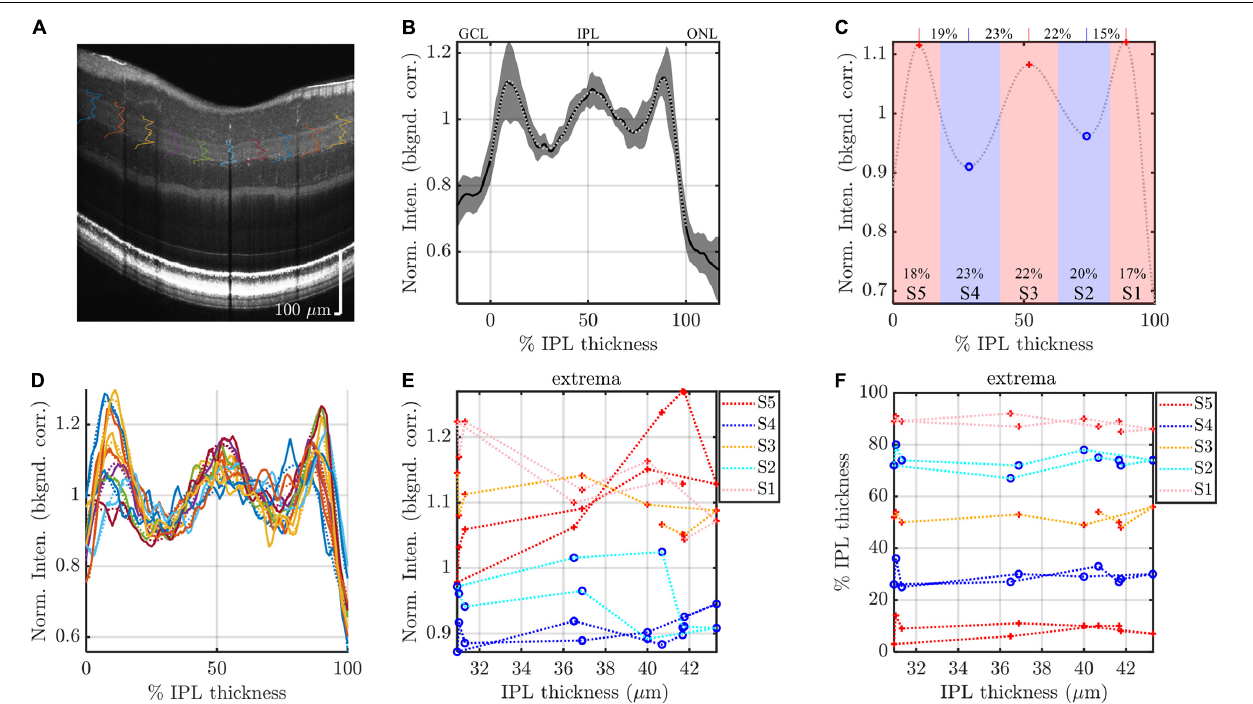
FIGURE 3 | Segmental analysis: example analysis of IPL segments to evaluate topography. (A) IPL intensity profiles (background corrected, averaged transversally over 1.5 ◦ segments, and normalized) are displayed across the image. As in Figure 2 , the average IPL profile (B) , with polynomial fit and derived stratification parameters (C) , are shown. (D) To evaluate topography, individual 1.5 ◦ segments are analyzed. Each segmental polynomial fit (dotted lines in D ) provides extrema (E) and their locations (F) , using the image-averaged profile (C) as a template (see main text). Red crosses are segmental maxima and blue circles are segmental minima. This segmental analysis reveals variations in stratification with either IPL thickness (abscissa in E,F ) or eccentricity. Data from consecutive segments are connected with dotted lines.